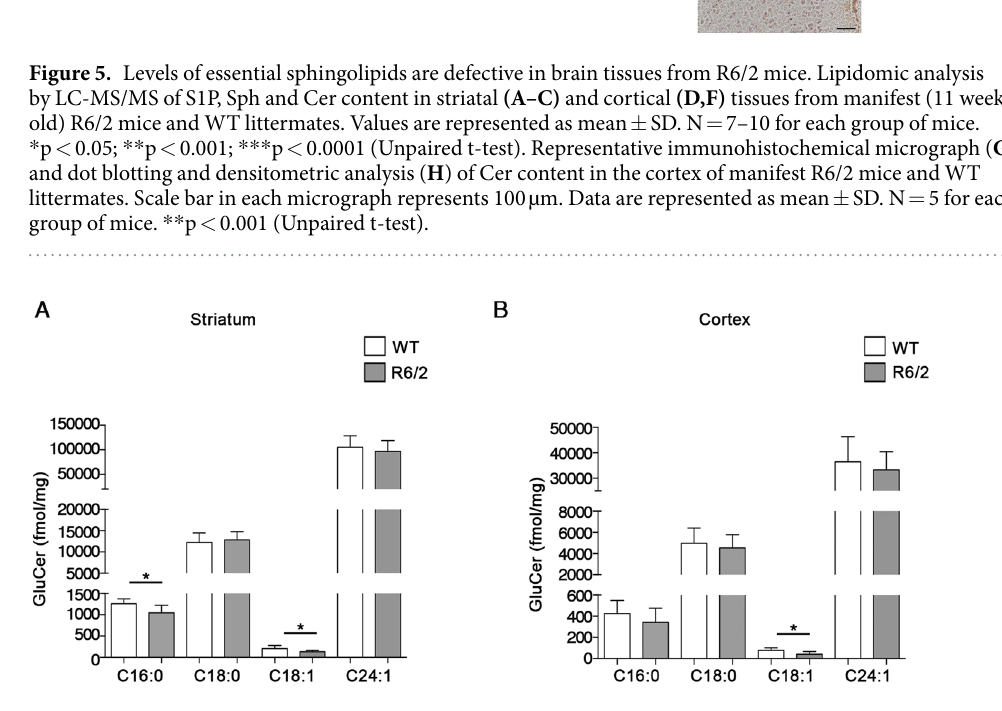
Figure 6. Levels of Glucosylceramides (GluCer) are reduced in brain tissues from R6/2 mice. Lipidomic analysis by LC-MS/MS of GluCer content in the striatal ( A ) and cortical ( B ) tissues from manifest (11 week old) R6/2 mice and WT littermates. Values are represented as mean ± SD. N = 7 for each group of mice. ** p < 0.001(Unpaired